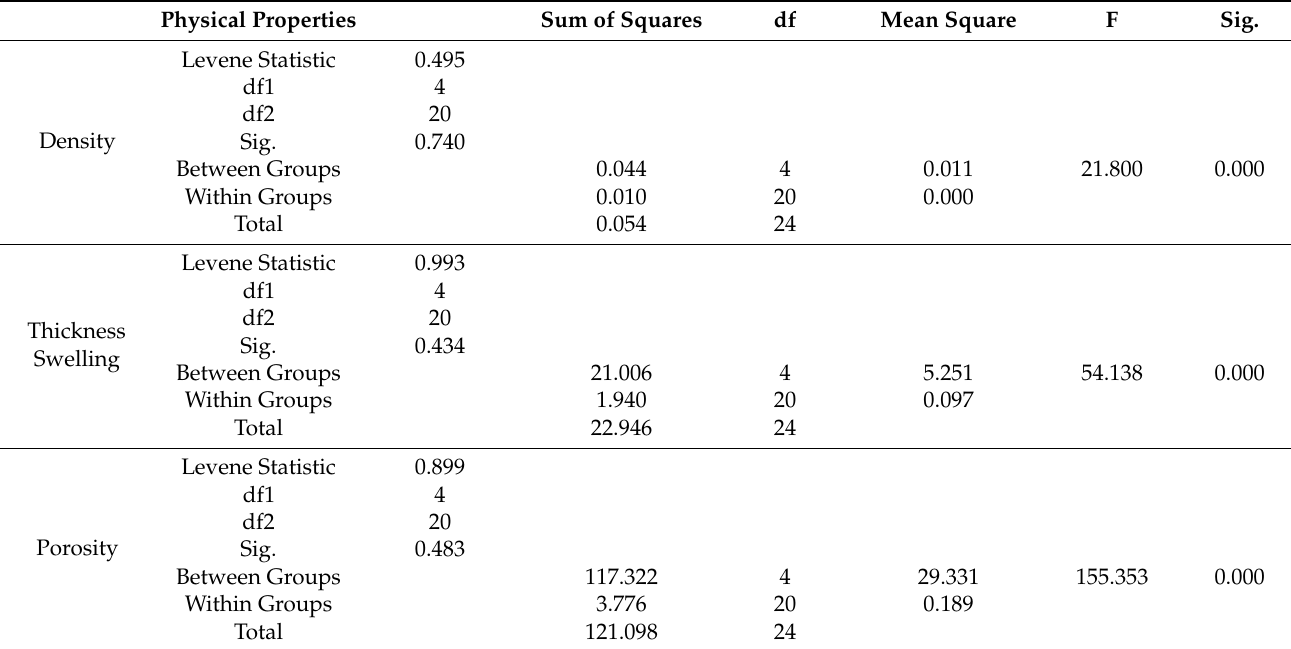
Table A1. Analysis of variance for physical properties with various PP compositions.